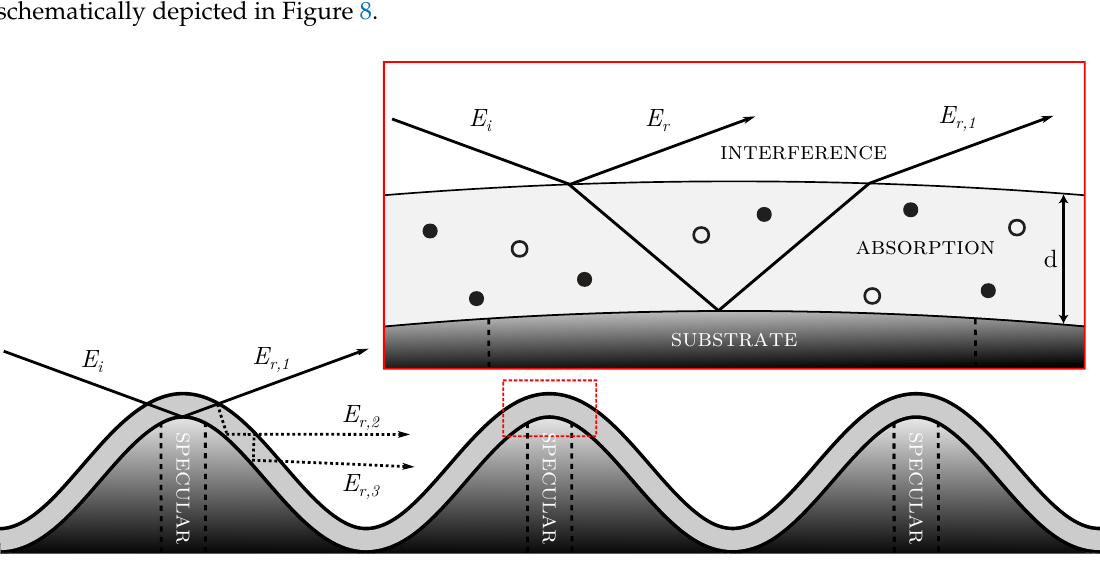
Figure 8. Sketch of the interaction of an incident electric field E i with the investigated substrate. The inset illustrates the use of a grazing incidence: Incident light strikes primarily the mountains of the height distribution where the curvature of the latter can be neglected for E r as well as for E r ,1 , thus leading to an approximately flat